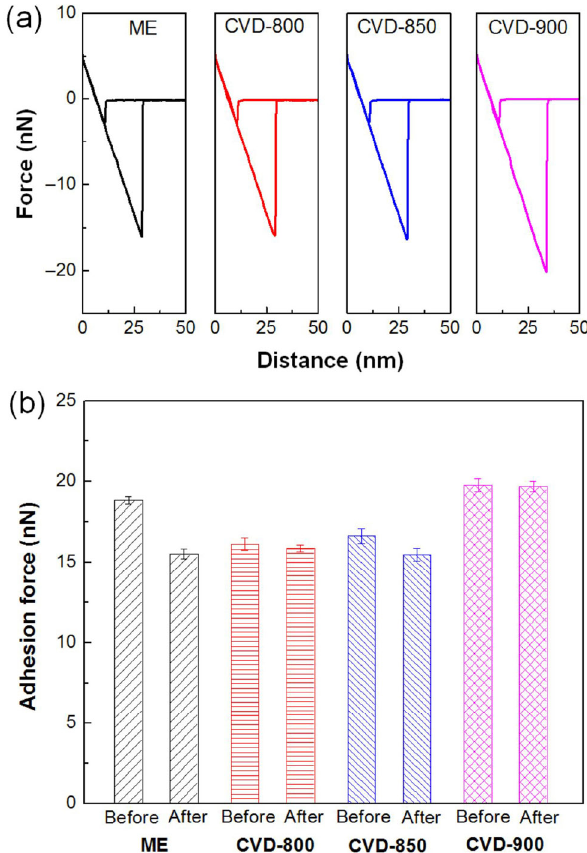
Fig. 3 (a) Examples of force-distance curves and (b) average adhesion forces of the mechanically exfoliated single-layer MoS 2 and CVD-grown single-layer MoS 2 at 800 ° C, 850 ° C, and 900 ° C. In (b), the adhesion forces obtained before and after friction loop measurements are compared. In (b), the error bar represents one standard